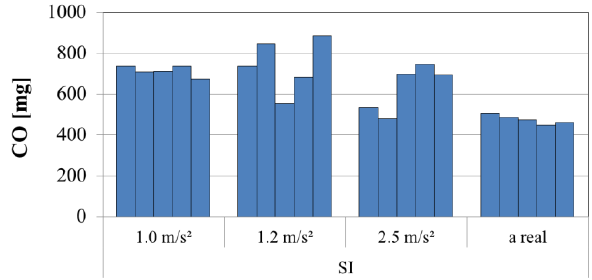
Fig. 13. CO emissions for different acceleration characteristics of a vehicle propelled with SI Euro 3 engine obtained during simulation using PTV Vissim software